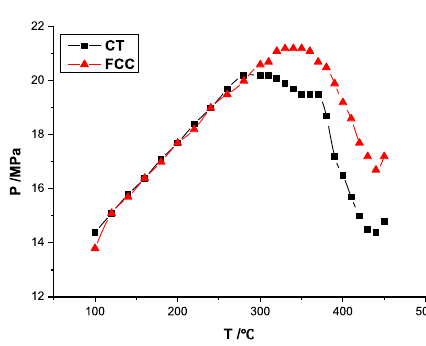
Fig. 4 The curve of pressure changes with